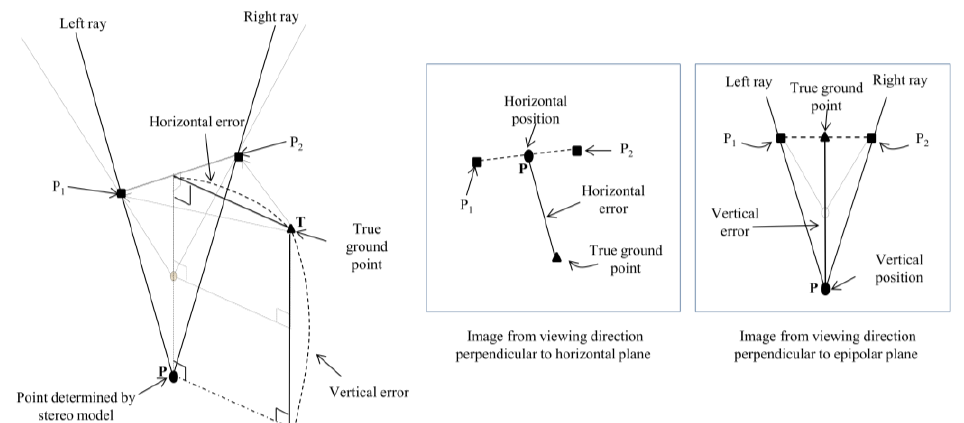
Figure 6. Effects of changes in the convergence angle on the stereo geometry and positioning accuracy (Jeong and Kim, 2014).